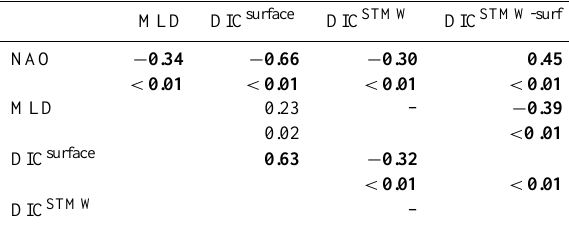
Table 3. Correlation table of selected mean winter (JFM) variables. Within each cell, the first row is the correlation coefficient and sec- ond row is the p-value. For each correlation, N = 22–23. Only those correlations with P ≤ 0.1 are shown, with P ≤ 0.01 in bold. MLD DIC surface DIC STMW DIC